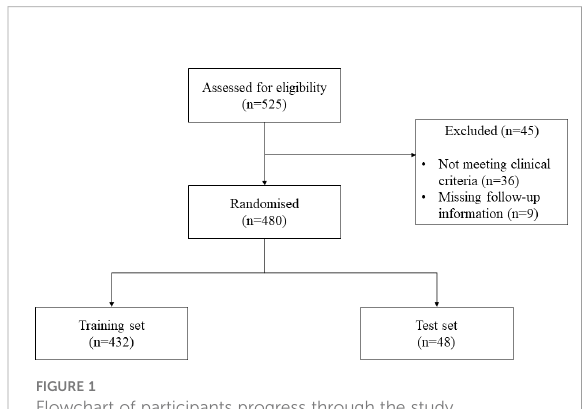
FIGURE 1 Flowchart of participants progress through the